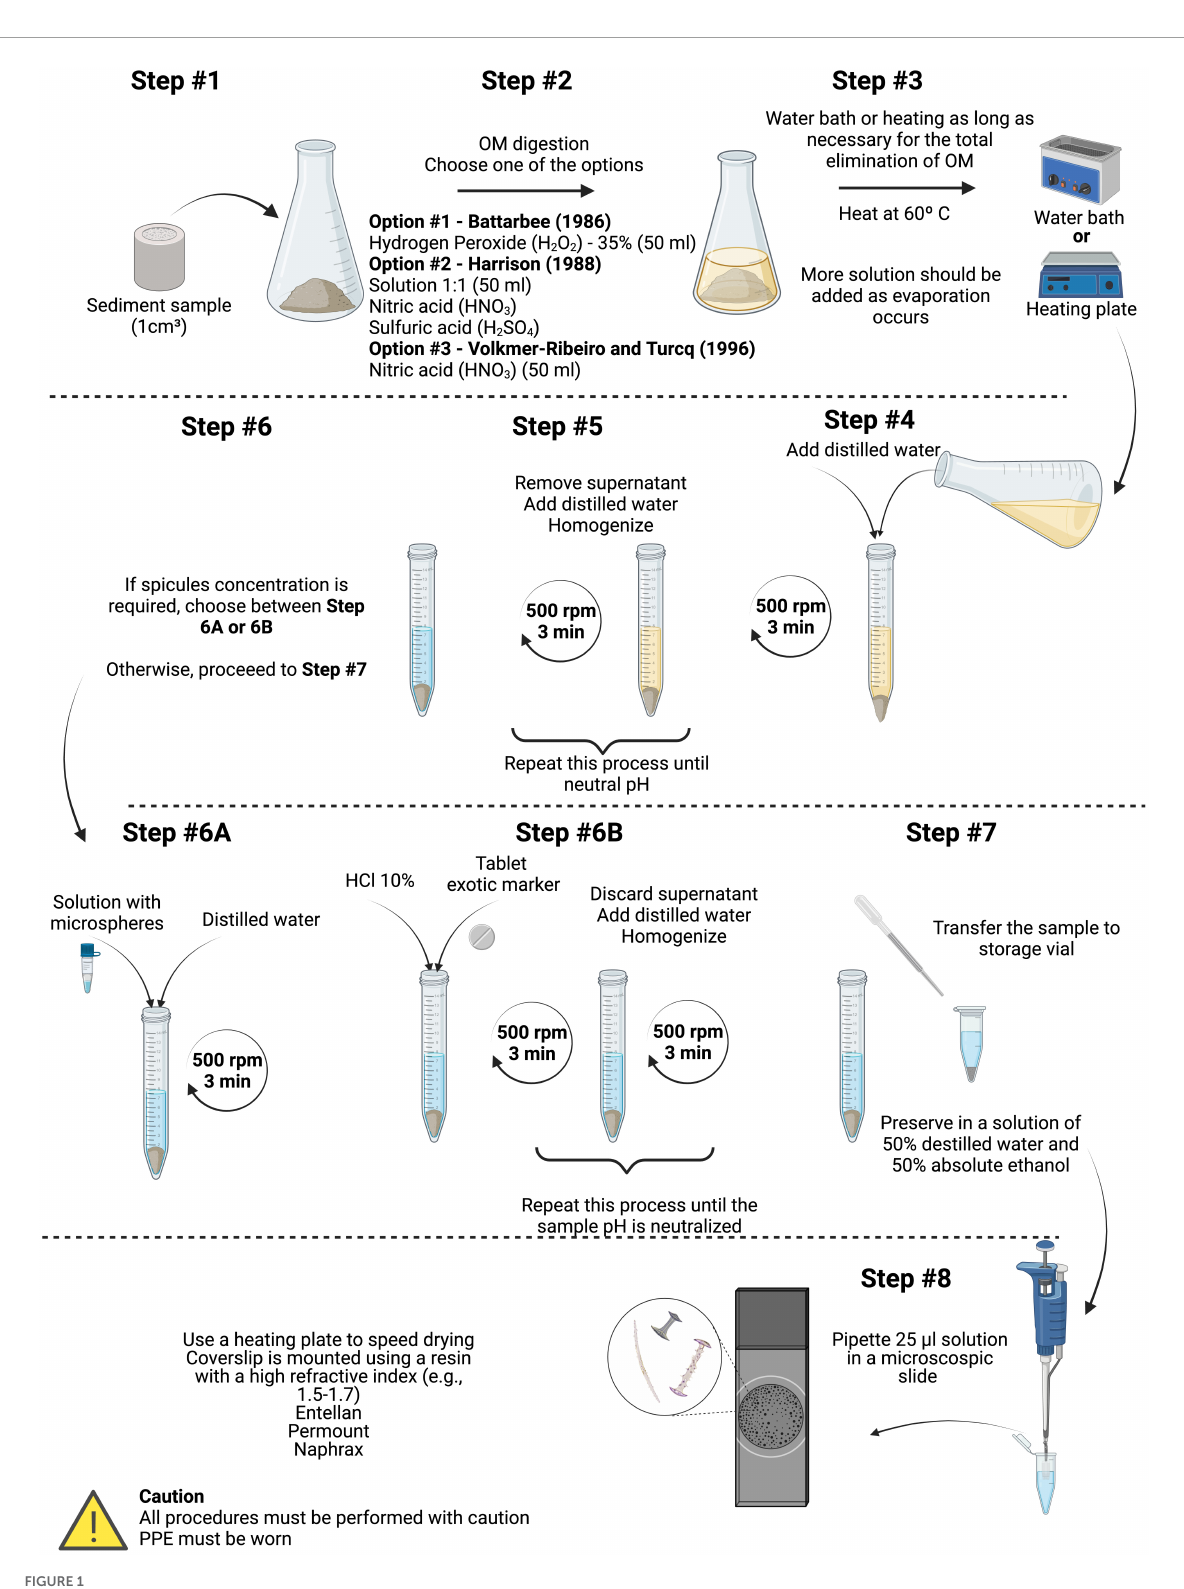
Frontiers in Ecology and